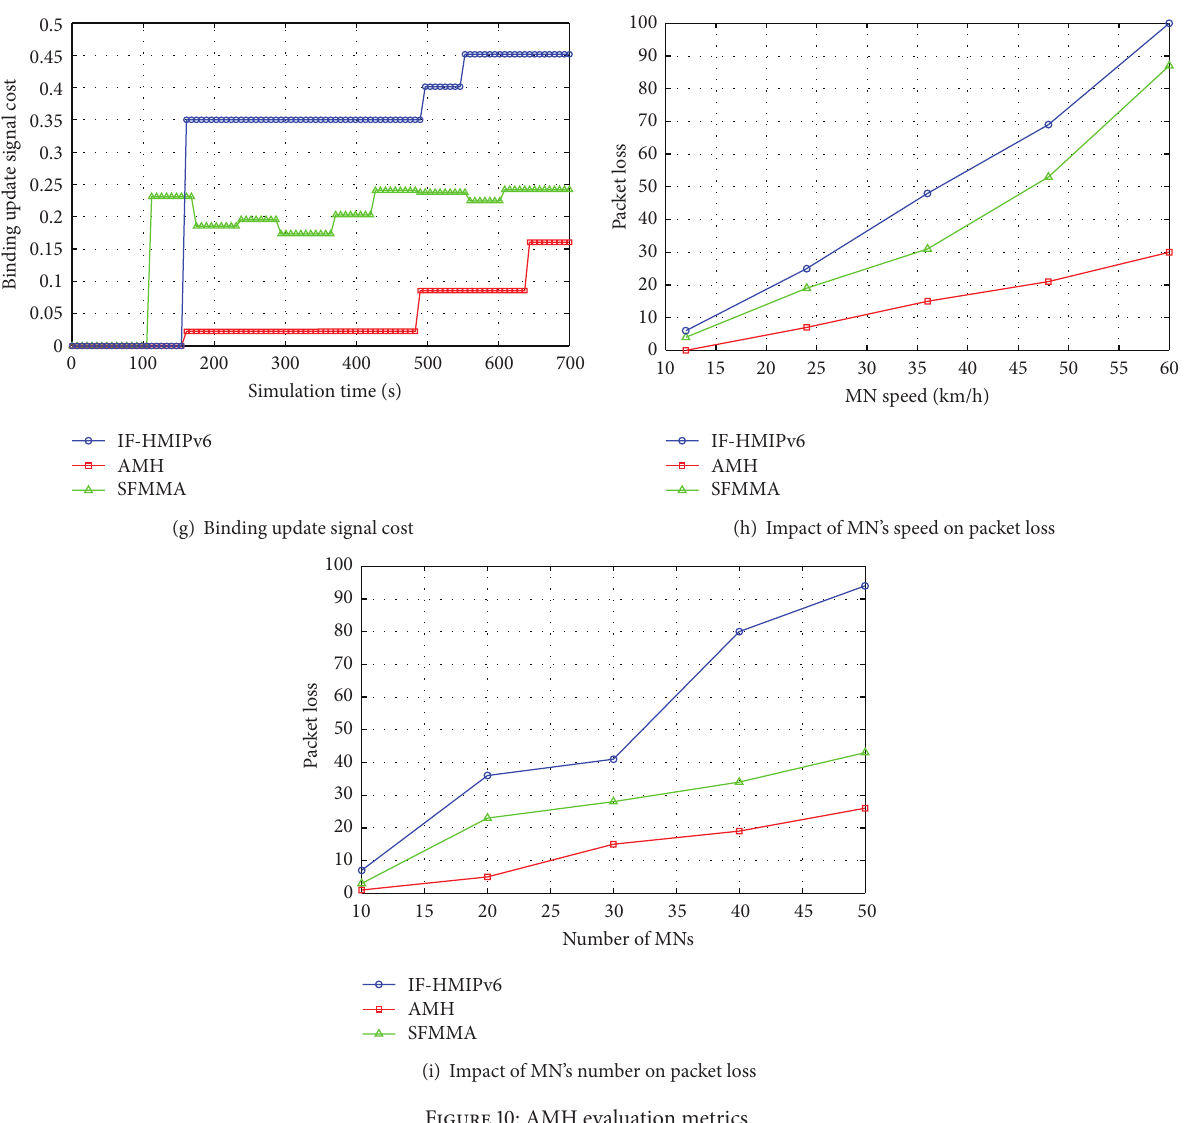
Figure 10: AMH evaluation